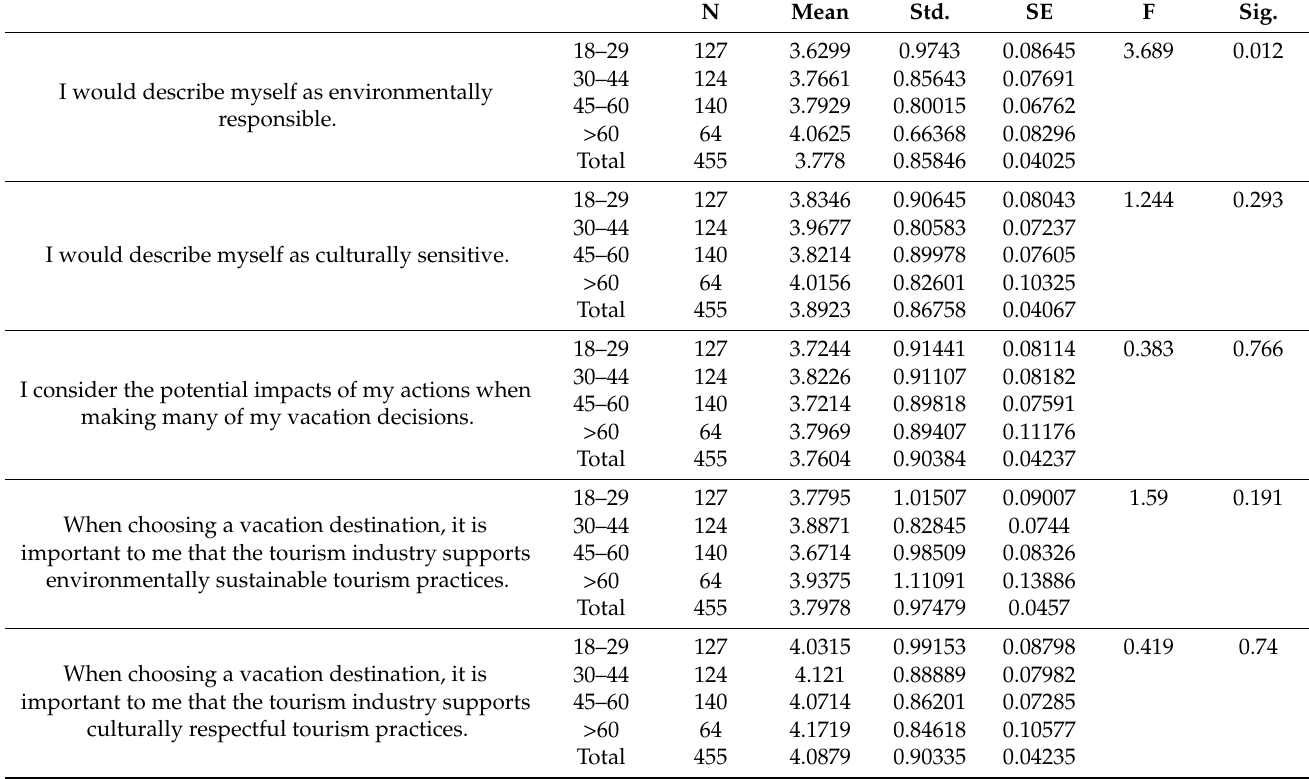
Table 8. Participants’ view of their responsibilities as leisure travelers, by